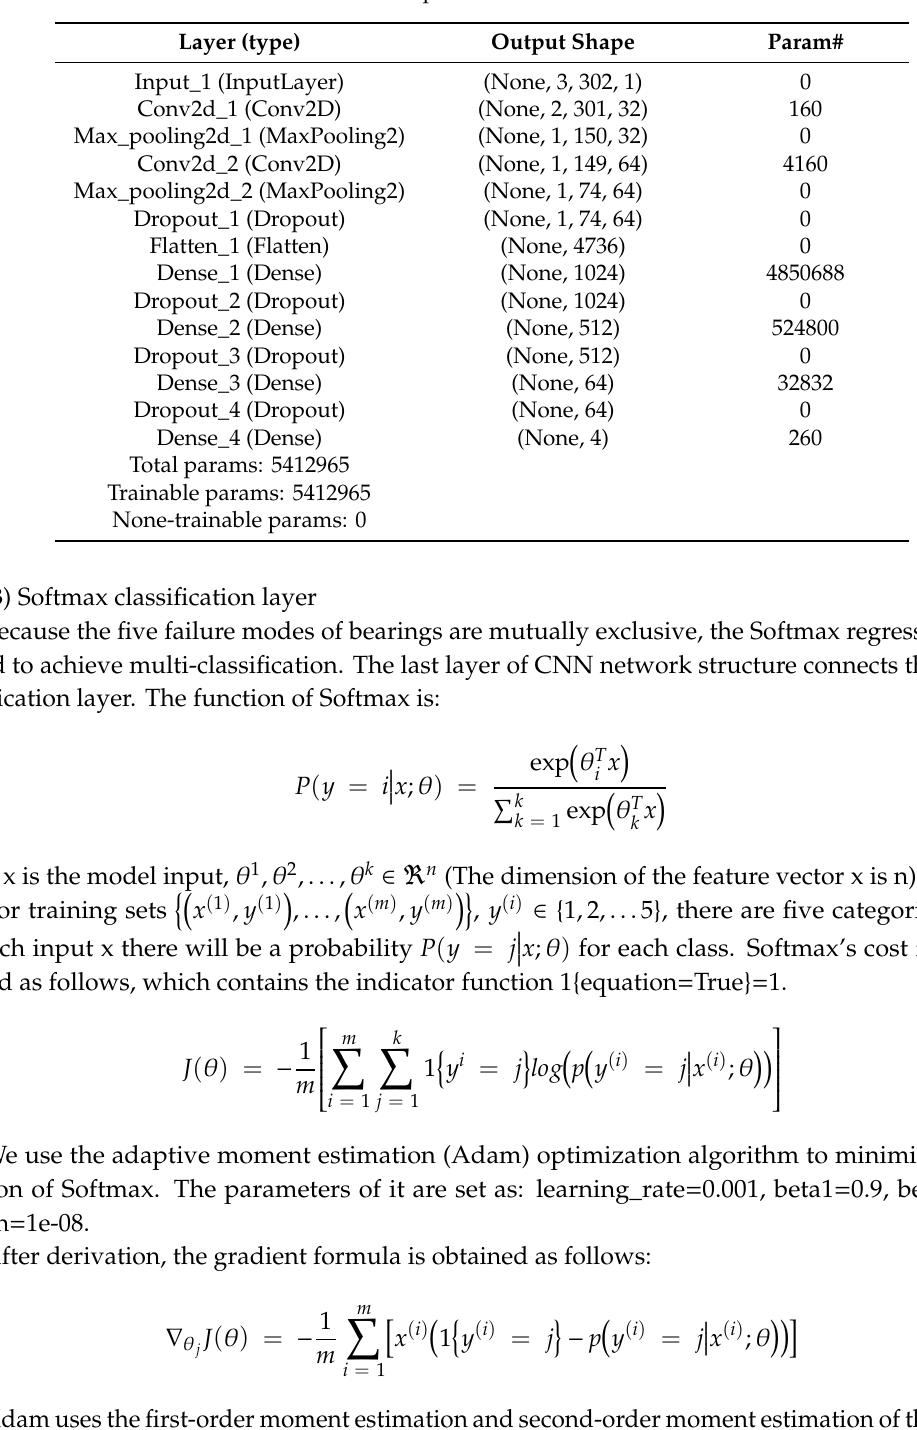
Table 4. Graph of network